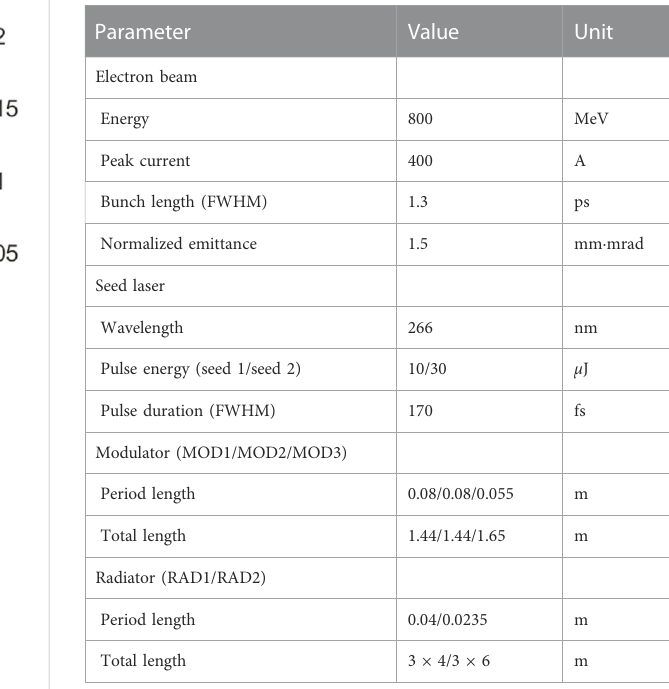
TABLE 1 Parameters for the SXFEL-TF